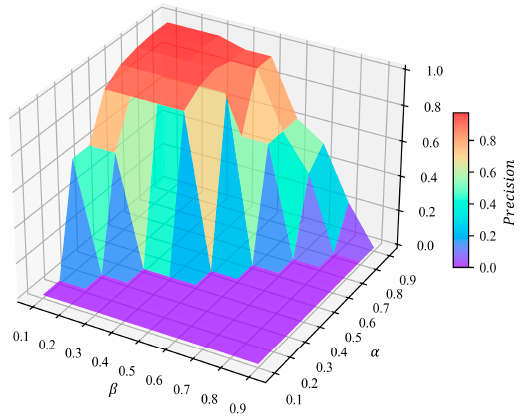
Figure 8. WDBC’s 𝑃𝑟𝑒𝑐𝑖𝑠𝑖𝑜𝑛 change chart. Figure 8. WDBC’s Precision change